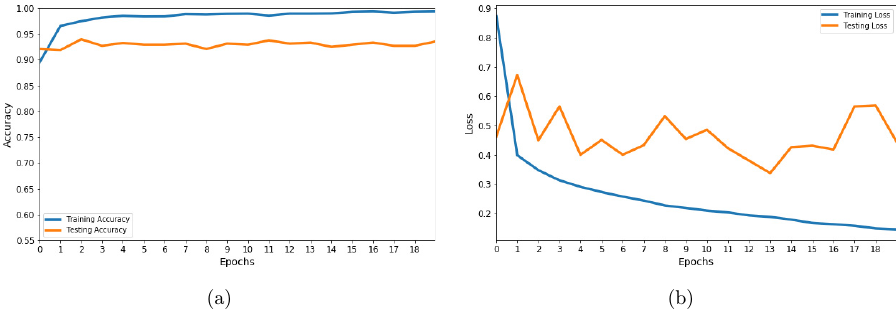
Fig. 9. Graph of the VGG19 þ FCN model: (a) Epochs vs. Accuracy (b) Epochs vs. Loss.